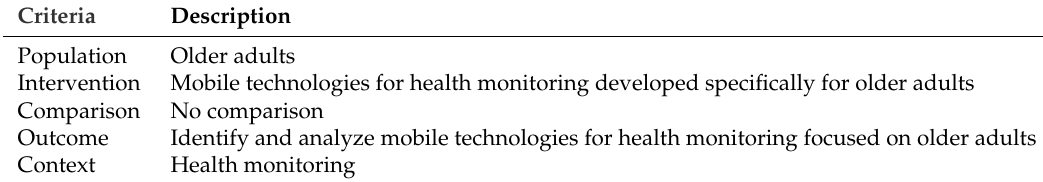
Table 1. Research questions as structured by the PICOC